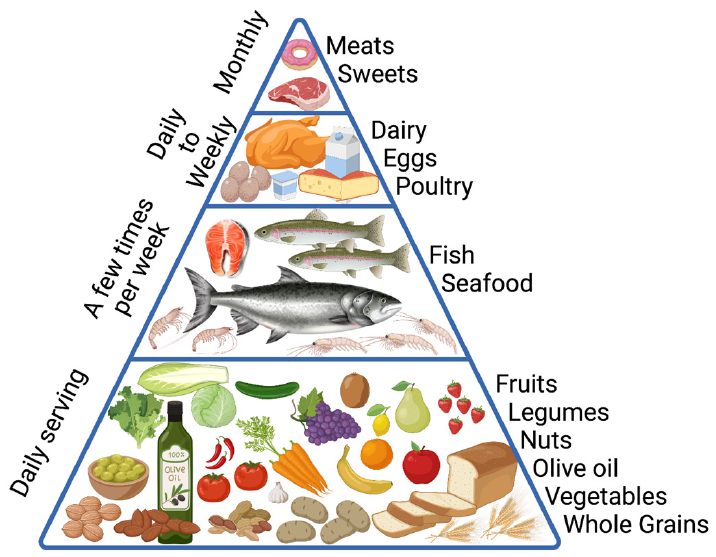
Figure 2. Mediterranean diet pyramid, adapted from [33]. According to the eating habits of long- living adults in the Mediterranean basin, the pyramid summarizes the type and frequency of foods that constitute the Mediterranean dietetic pattern. The pyramid is divided into daily, weekly, and monthly frequencies (created with BioRender.com, accessed on 12 October 2022).